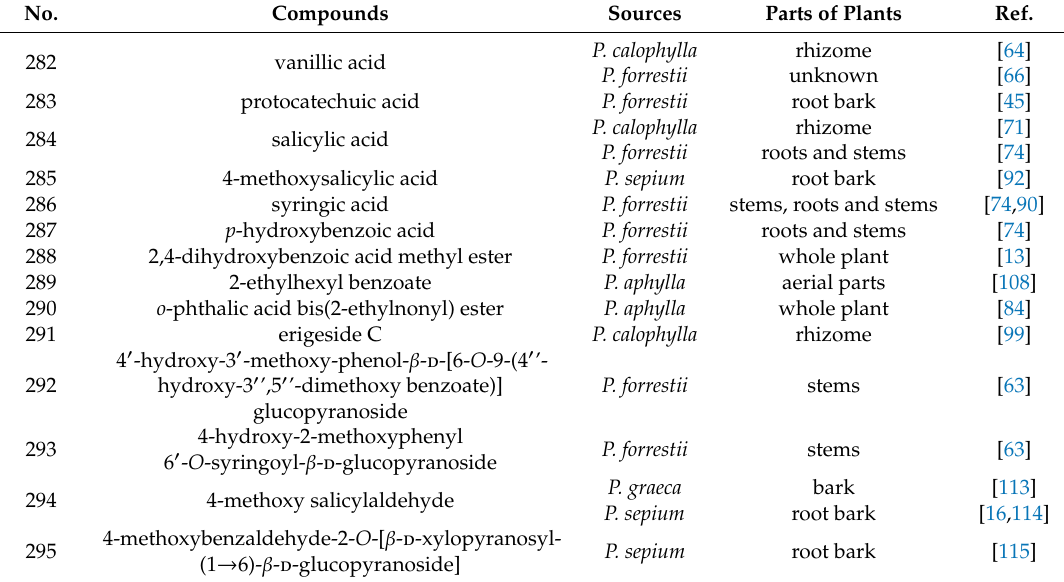
Table 8. Aromatics from the genus Periploca